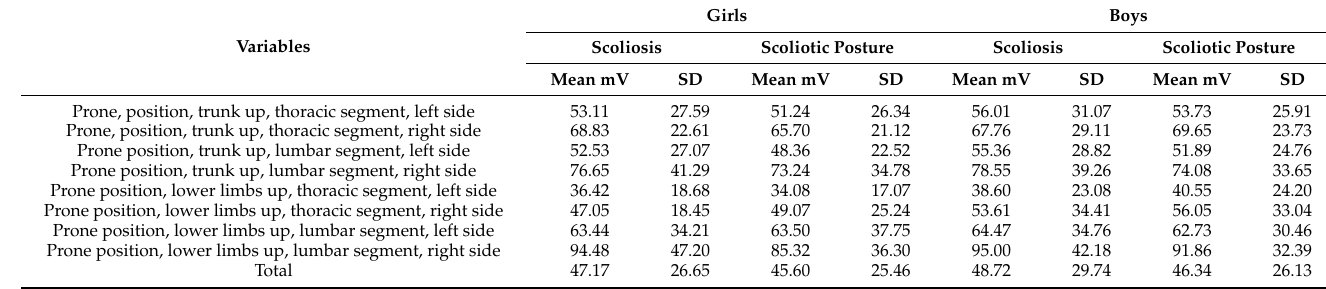
Table 2. Muscle tone of the erector spinae (sEMG amplitude).